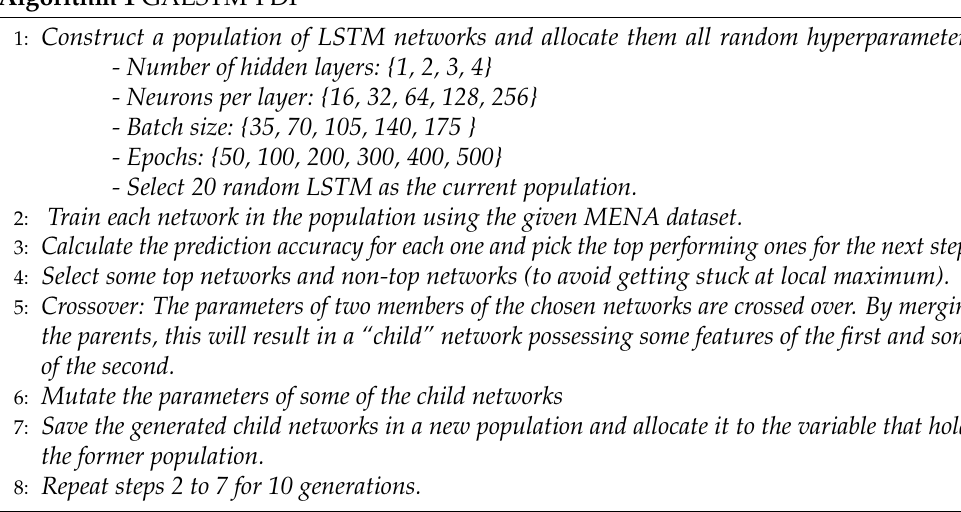
Figure 3. Optimizing the LSTM model using GA for FDP. Algorithm 1 involved in this study is given below: Algorithm 1